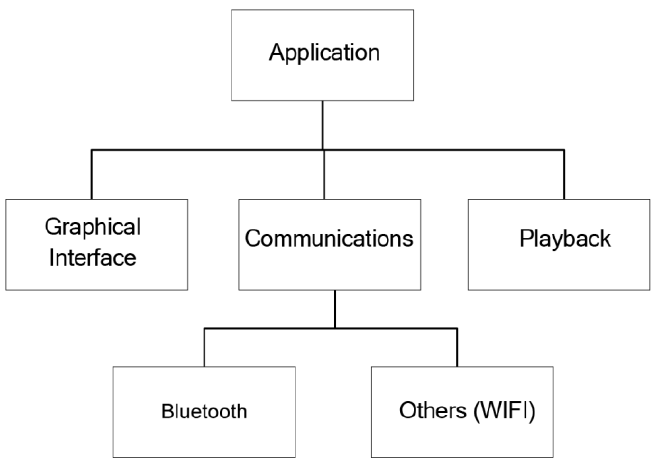
Figure 4. Modular structure of the Client Application.